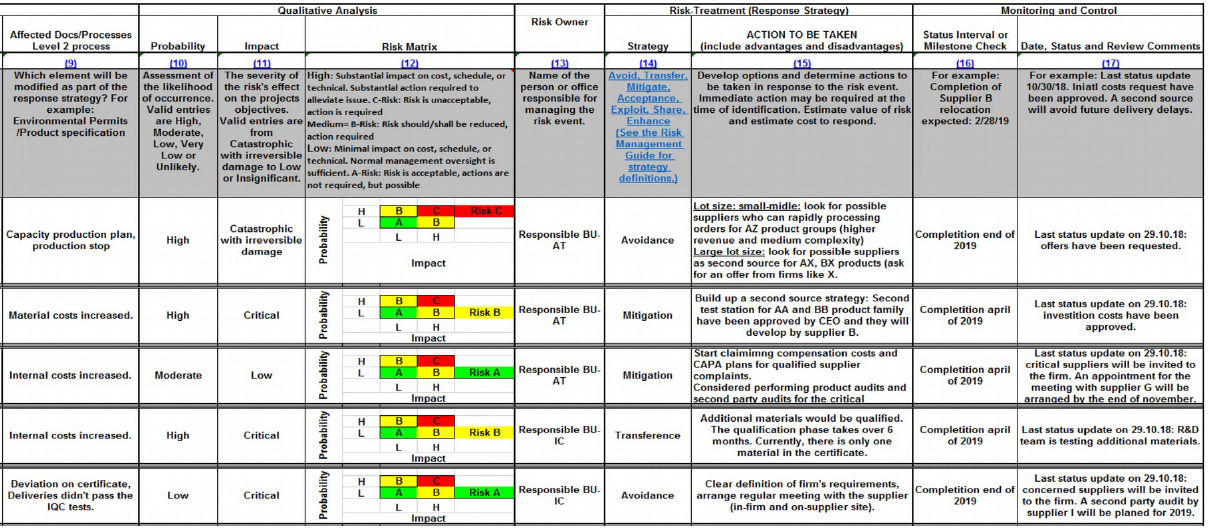
Figure 8. SCRM plan (b) Case